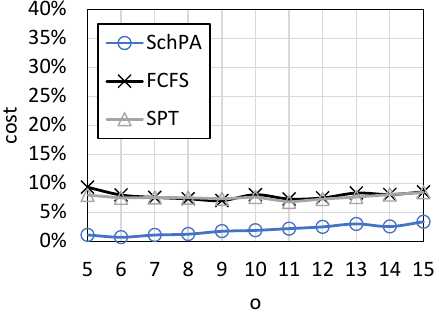
Figure 15. Comparison under varying o .